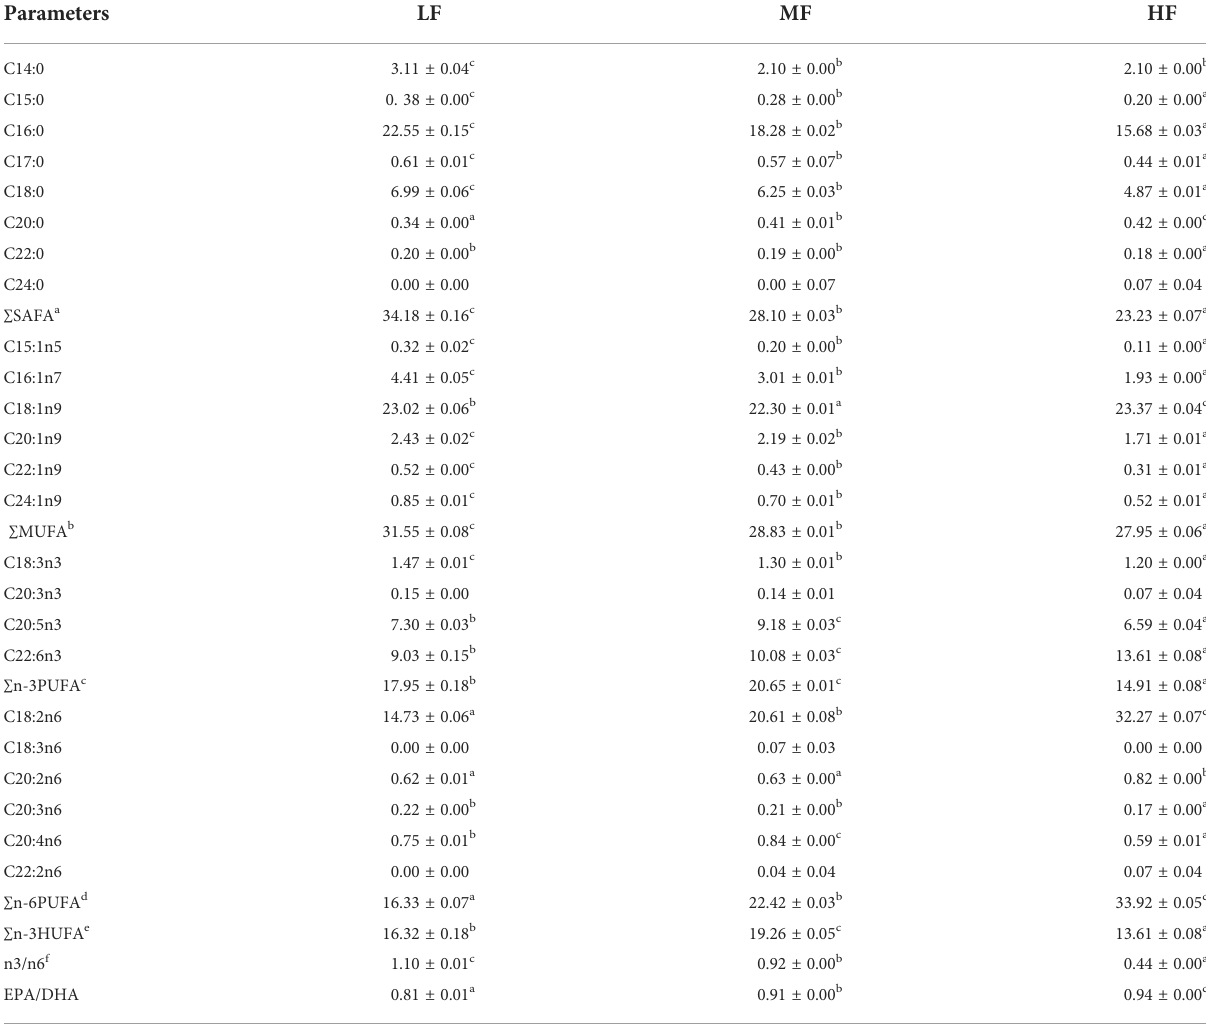
TABLE 7 Effect of dietary lipid levels on fatty acid composition of muscle in hybrid grouper (%total fatty acids).